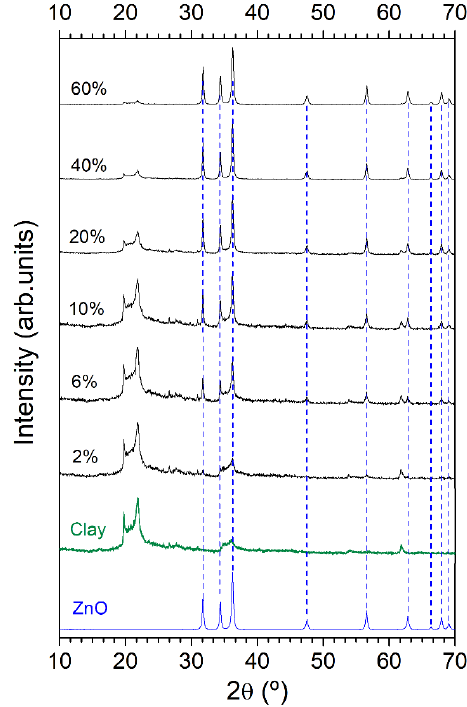
Figure 1. Structural characterization of ZnO obtained and ZnO/Clay composites. XRD diffractograms of ZnO, bentonite clay and modified clay with different compositions of ZnO (from 2% to 60%).